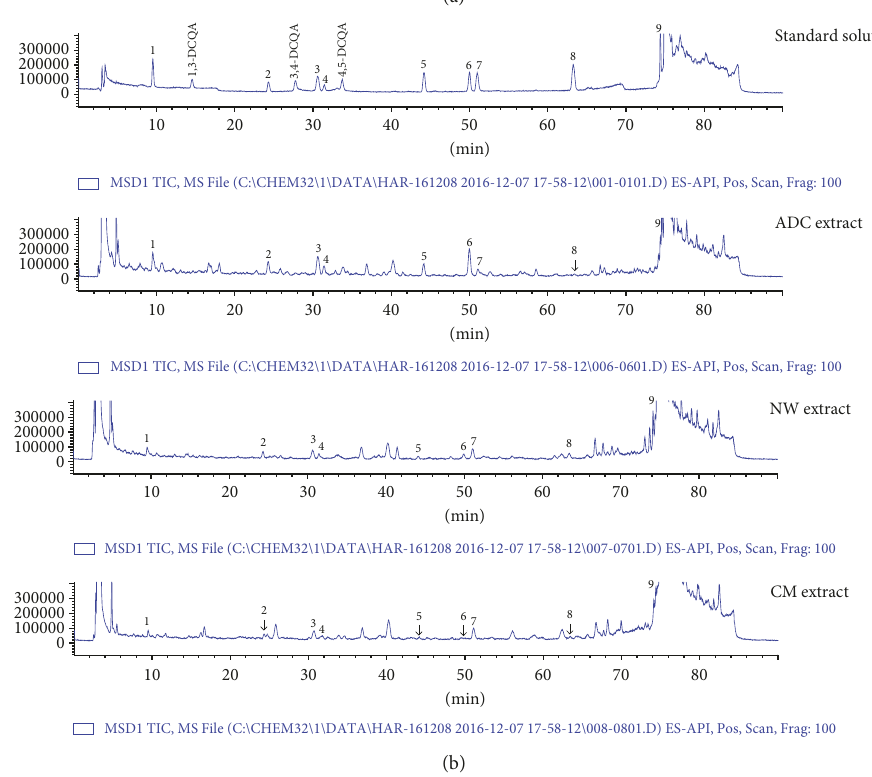
Figure 3: (a) HPLC chromatograms at 280 nm and (b) the expansion of total ion chromatograms in the positive ion mode. For the identification of each numbered peak, see Table